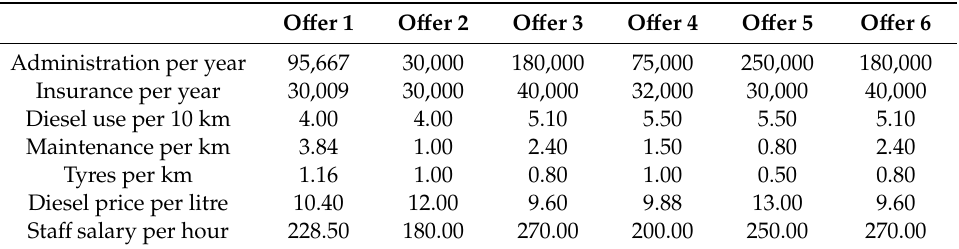
Table 1. Agent estimates of cost factors for the Oslo region waste electrical and electronic equipment (WEEE) collection